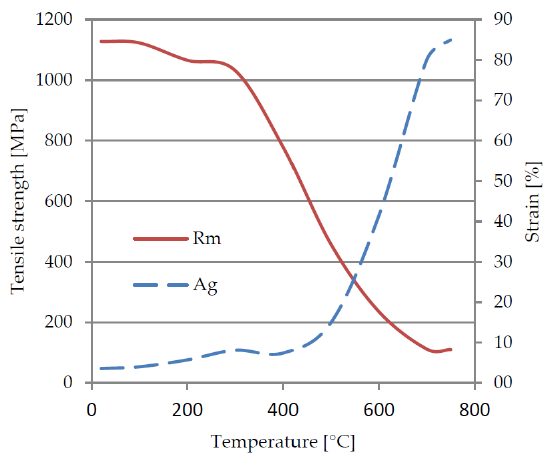
Figure 3. The effect of heating temperature on the mechanical properties of HCT980C steel. Rm = maximum tensile strength and Ag = elongation percentage.